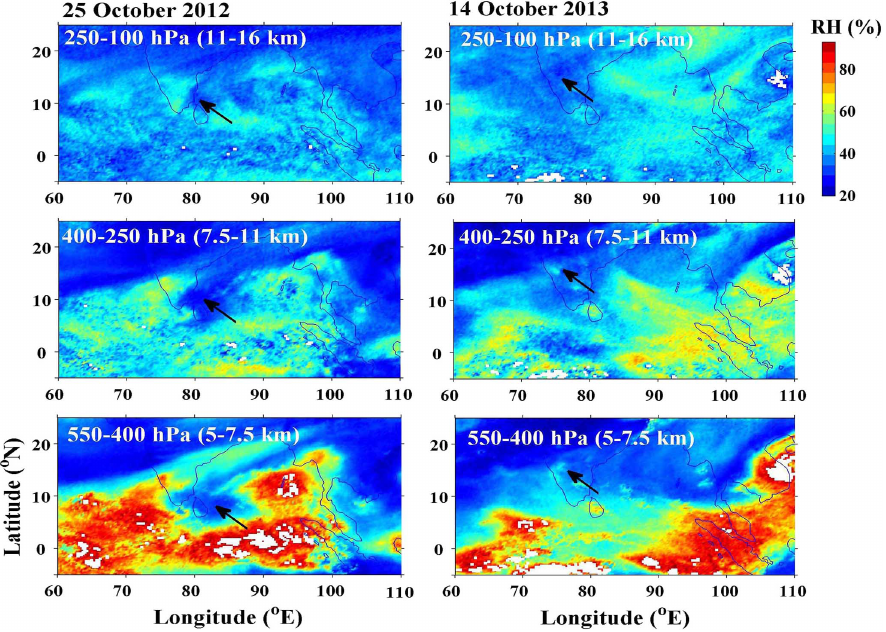
Figure 8. Latitude–longitude distribution of relative humidity derived from SAPHIR on board the Megha-Tropiques at different pressure levels (stamped on each panel) for Nilam (25 October 2012) and Phailin (14 October 2013). The data is averaged for one day, which is about 12–14 passes at different timings, and arrows indicate the presence of dry